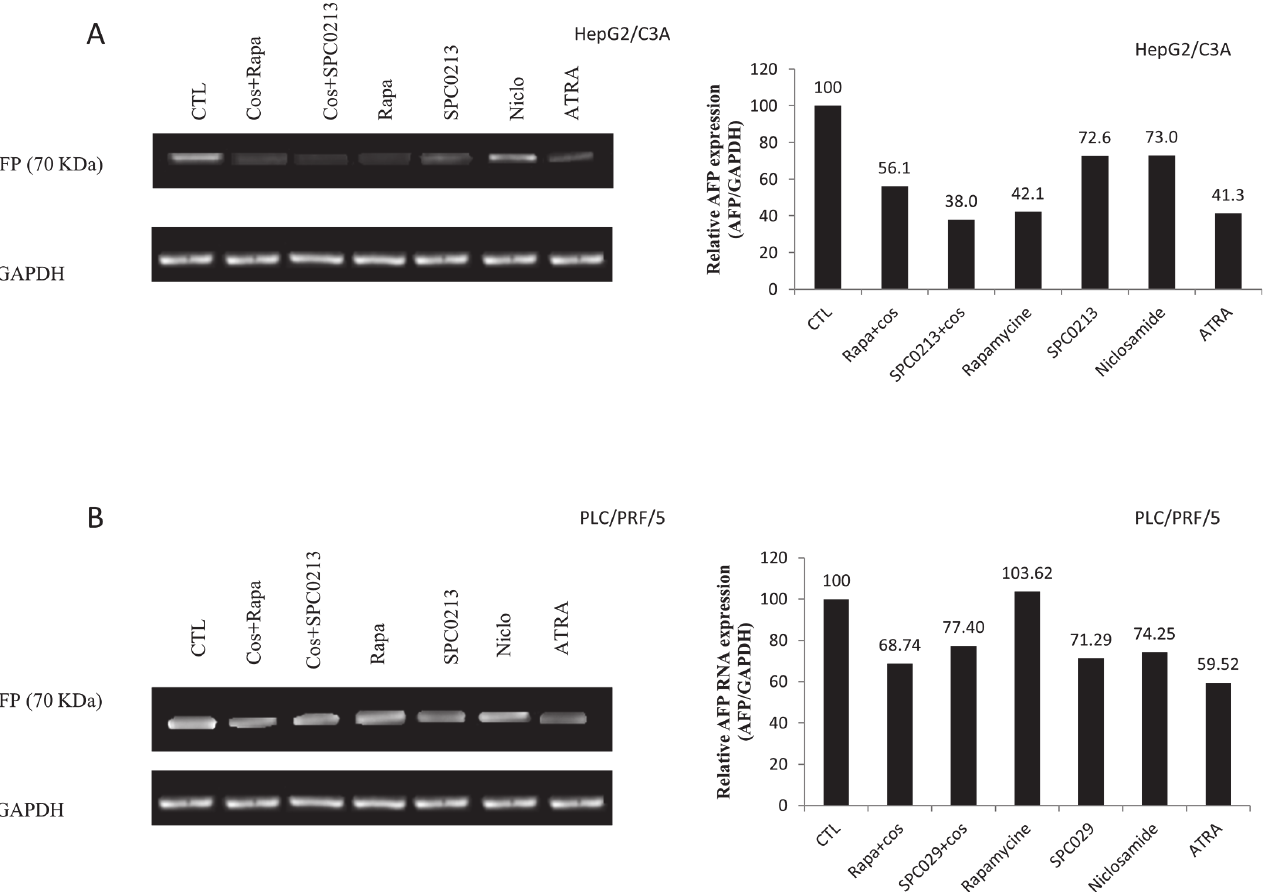
Fig 11. Effect of pathway inhibitors on AFP mRNA in HepG2/C3A and PLC/PRF/5 cells. The cells were seeded in a six-well plate at a density of 10 4 cells/well. At 80% confluence, the cells were treated with inhibitors of PI3k/mTOR/Akt and costunolide for 48 h. The cell RNA was then extracted for RT- PCR, and this step was followed by cDNA amplification. The cDNA was then run in a 2% agarose gel and visualized by SYBR Safe staining. The relative mRNA levels were obtained using the Gel Analyzer software. Each experiment was repeated at least three different times.